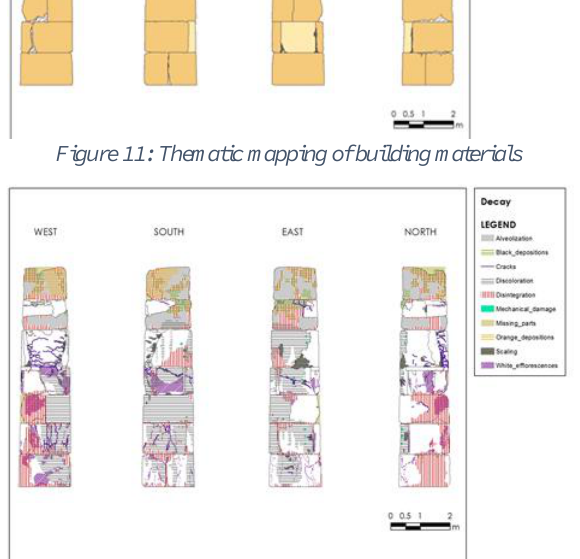
Figure 12: Thematic mapping of decay